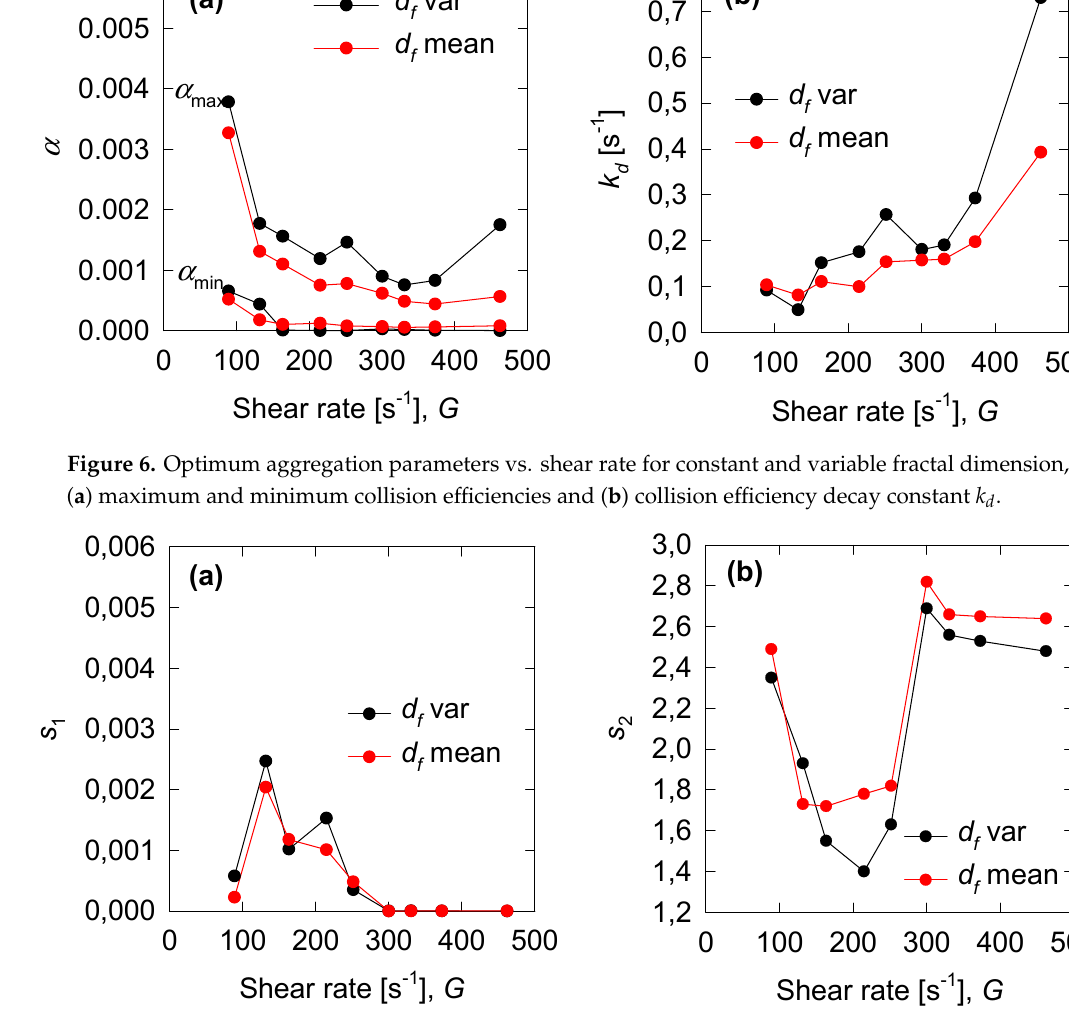
Figure 7. Optimum breakage parameters vs. shear rate for constant and variable fractal dimension, ( a ) 𝑠 (cid:2869) and ( b ) 𝑠 (cid:2870) .